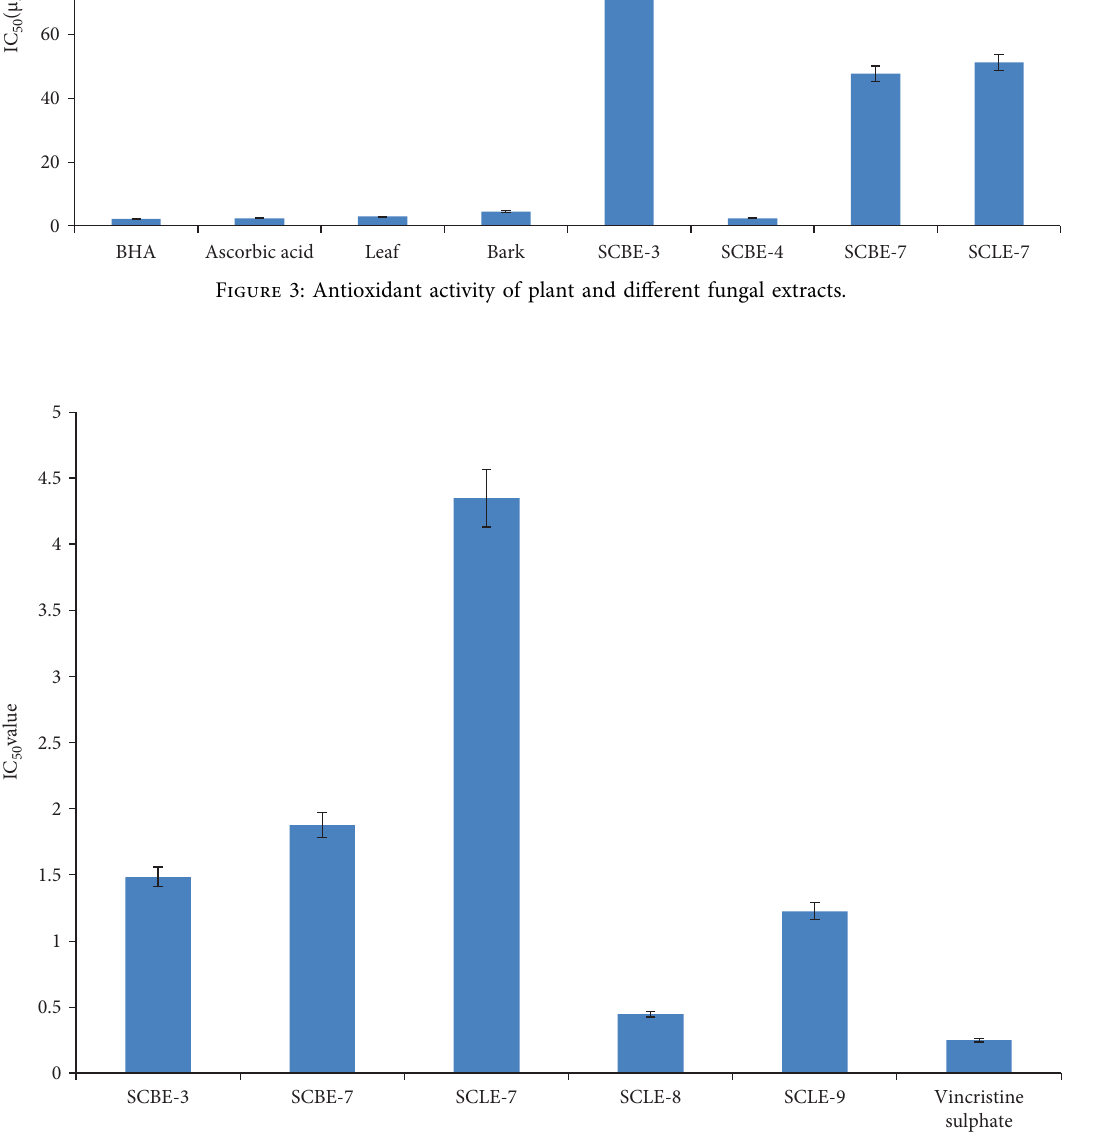
Figure 4: Cytotoxic activity of plant and diferent fungal extracts.